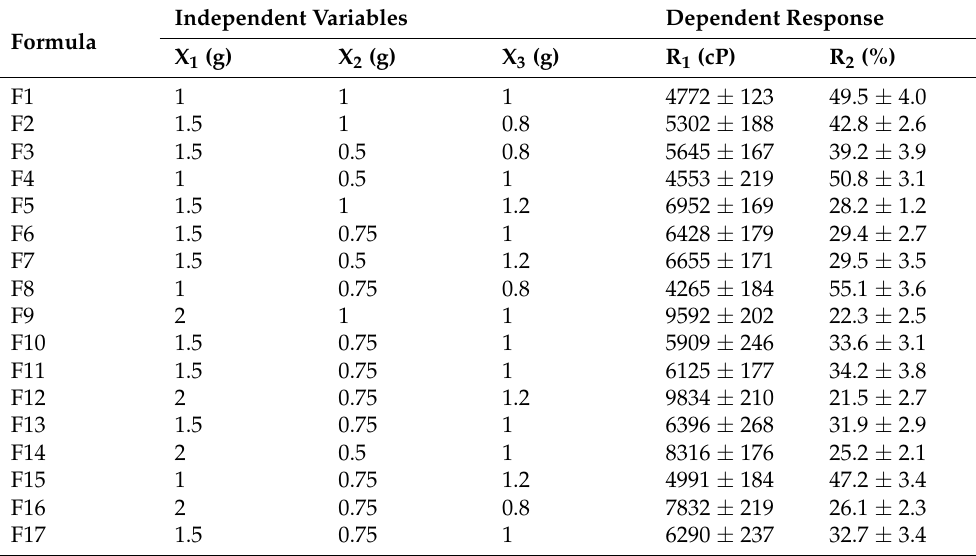
Table 1. Experimental design for different colchicine niosomal emulgel formulations and their observed values of response.